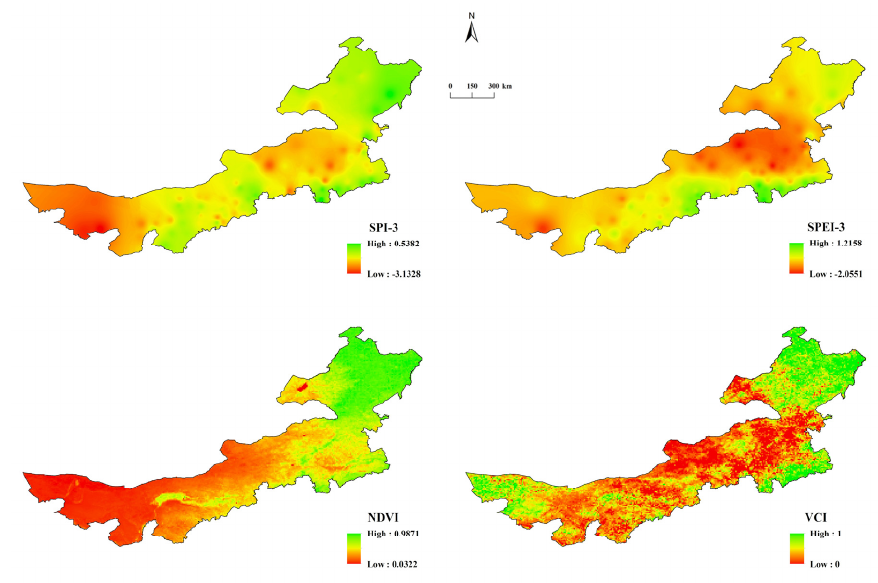
Figure 10. Spatial comparisons of the SPI-3, SPEI-3, normalized difference vegetation index (NDVI), and vegetation condition index (VCI) during typical drought events.